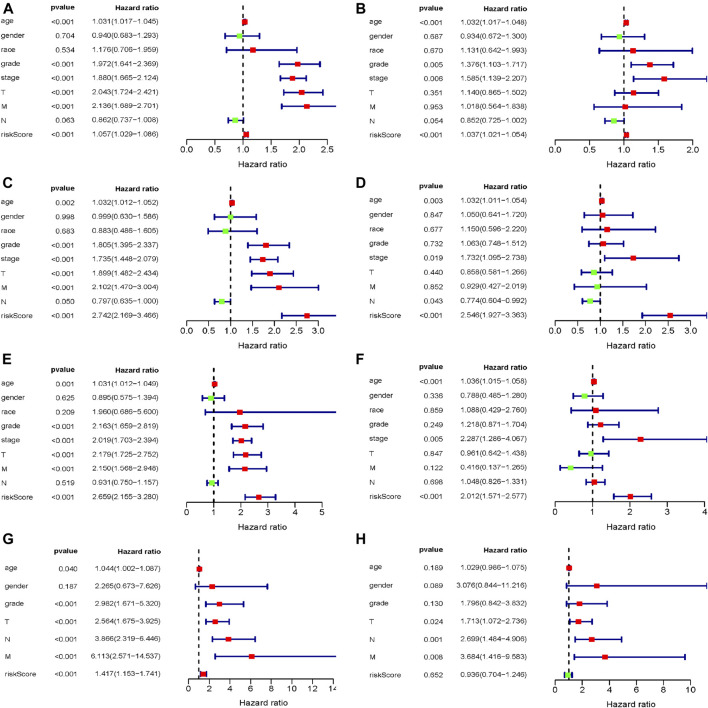
The evaluation of independent prognostic factor; (A,B) Univariate and multivariate Cox regression analysis of the whole training dataset (TCGA); (C,D) Univariate and multivariate Cox regression analysis of the internal validation dataset 1 (test 1); (E,F) Univariate and multivariate Cox regression analysis of the internal validation dataset 2 (test 2); (G,H) Univariate and multivariate Cox regression analysis of the external validation dataset (ArrayExpress).